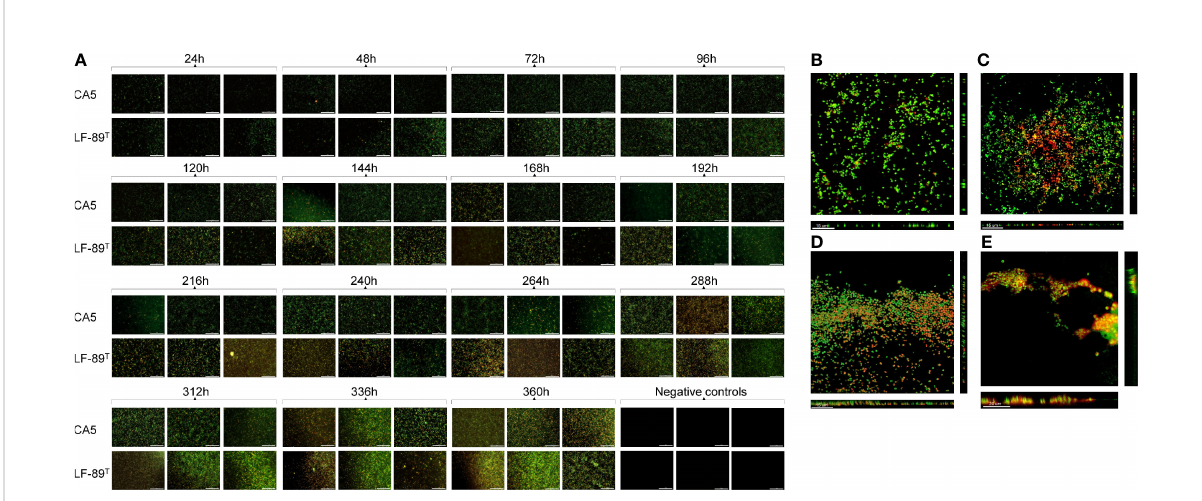
FIGURE 2 Automated imaging of bio fi lm development in 96 ‐ well microplates and SCLM micrographs of 48-h-old bio fi lms. (A) Bio fi lms of P . salmonis LF- 89 T and CA5 on the bottom of wells (including negative-control wells containing sterile AUSTRAL-SRS broth) were stained with the LIVE/DEAD bacterial viability kit at different times. For SCLM, 48-h-old bio fi lms of P . salmonis (B, C) LF-89 T and (D, E) CA5 were stained with the (B, D) LIVE/DEAD reagent or (C, E) fl uorophore-conjugated WGA and DAPI stain. Bacteria stained with DAPI are depicted in orange only for